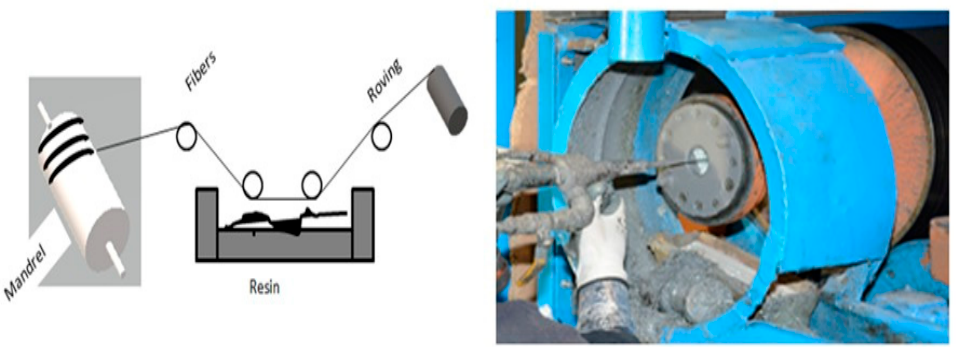
Figure 6. Filament Winding, and Centrifugal Process for Fabricating FRP Sections, adapted from Refs. [9–11].